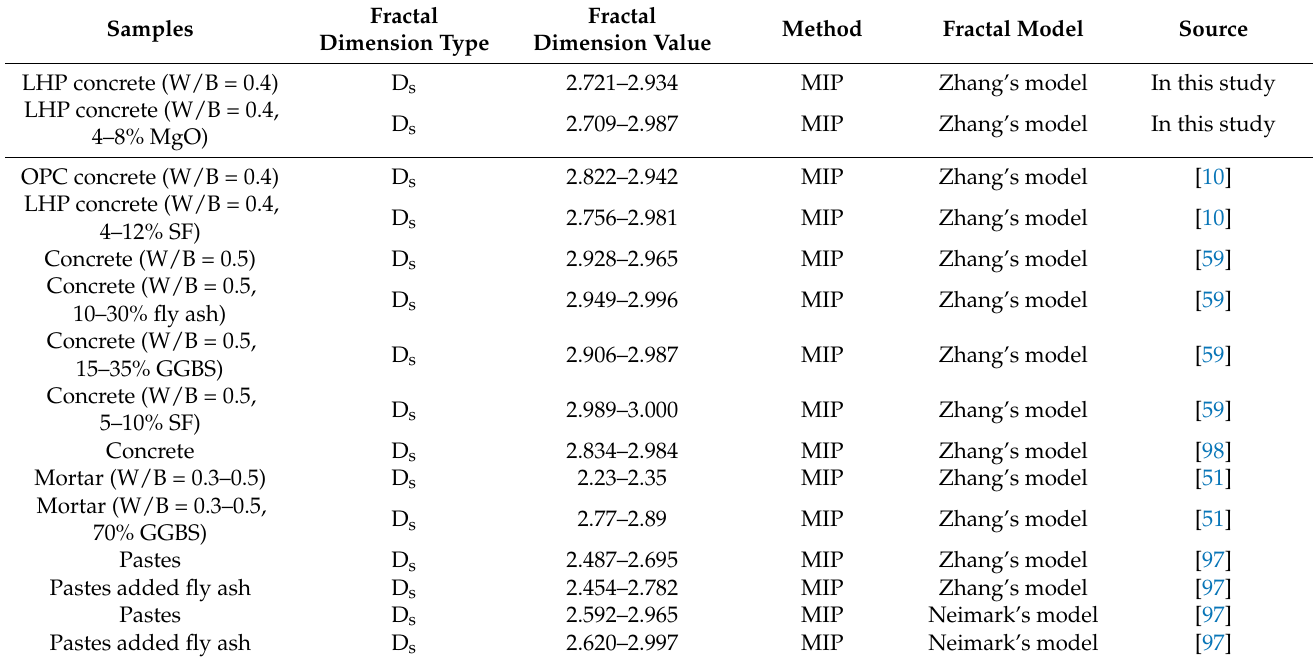
Table 6. Fractal dimensions determined by various fractal models in this study and other literature.